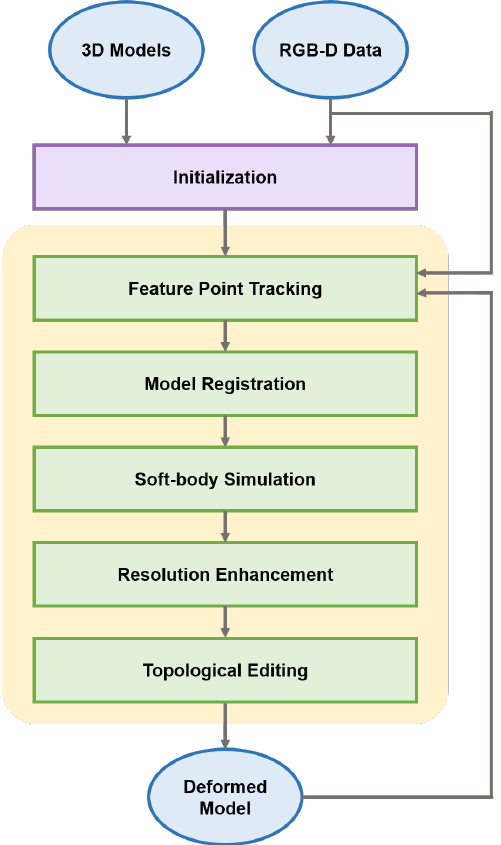
Figure 2. Overview of the proposed